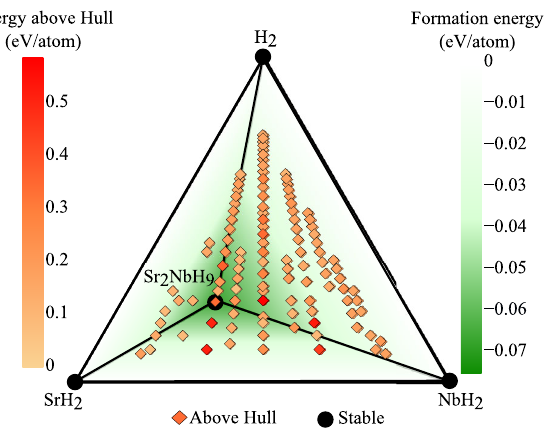
Fig. 6 The convex hull of the energies of the predicted structures for the NbH 2 -SrH 2 -H 2 materials system. The distance from the convex hull measures the thermodynamics stability of the various candidate compounds. The green shading indicates the formation energy of the thermodynamically stable compounds and mixtures relative to the three compounds NbH 2 , SrH 2 , and H 2 . We identify a previously unknown ternary hydride, Sr 2 NbH 9